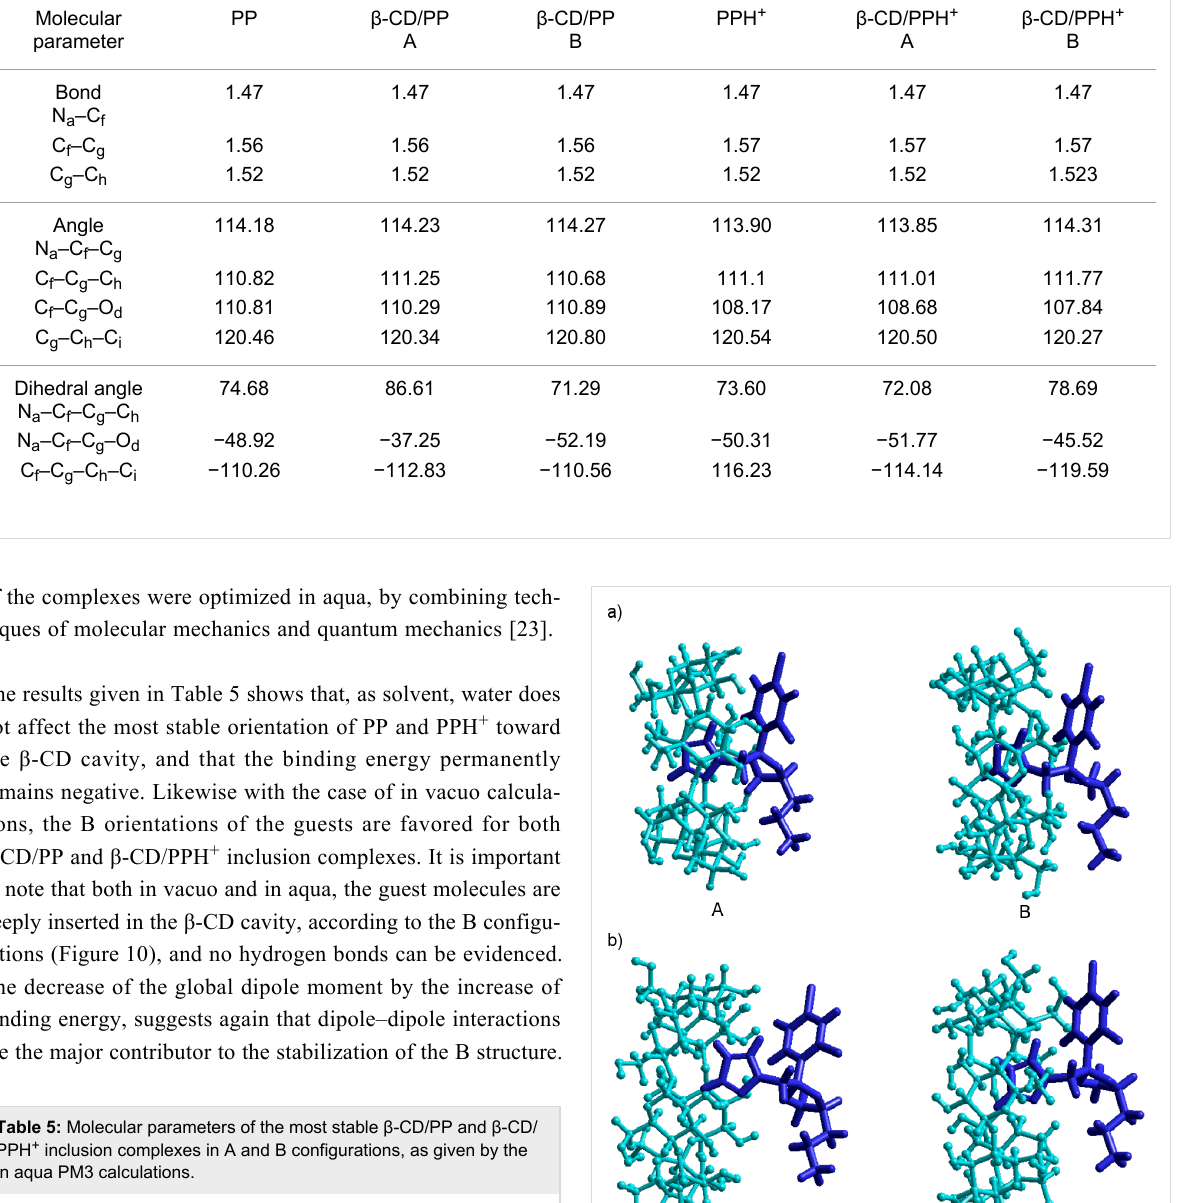
Table 4: Relevant geometric parameters of the PP and PPH + molecules in their inclusion compounds with β -CD, as given by PM3 calculations. Molecular parameter